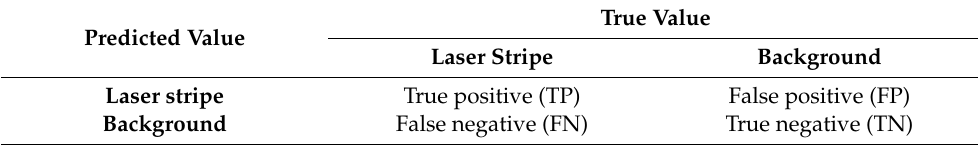
Table 4. Confusion